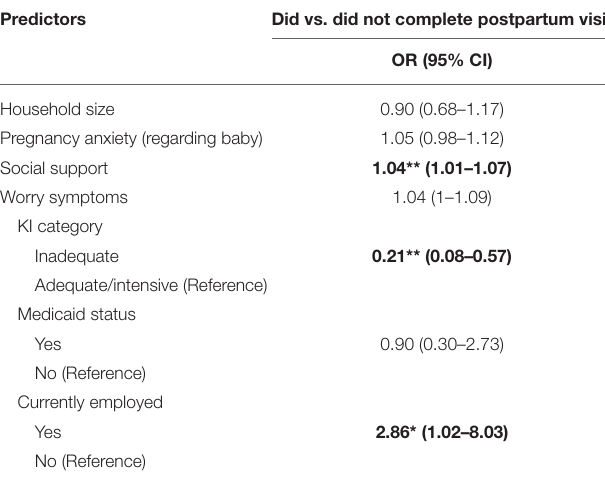
TABLE 5 | Multivariate binary logistic regression analysis predicting completion of postpartum